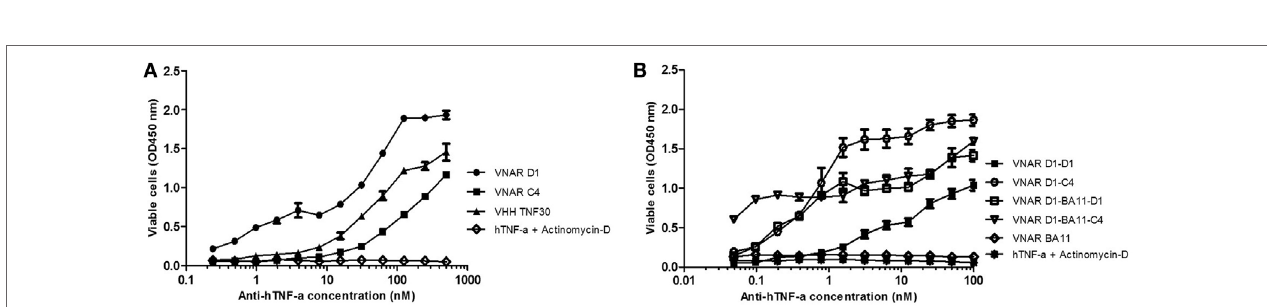
FigUre 3 | Efficacy assessment in standard L929 cell-based assay. Neutralization of 0.3 ng/ml hTNF- α -induced cytotoxicity in an actinomycin-D primed fibrosarcoma cell line (L929). (a) hTNF- α neutralization assay with anti-hTNF- α monomeric constructs at a maximum concentration of 500 nM. Results are the mean ± SD ( n = 2) with two replicates per experiment. (B) Neutralization with multivalent anti-hTNF- α variable new antigen receptor (VNAR) constructs at maximum concentration of 100 nM. Results are the mean ± SEM ( n = 3) with two replicates per experiment. Results (B) were analyzed statistically using a two-way ANOVA with Bonferroni’s multiple comparison post hoc test. VNAR BA11 was included as a negative control domain in all assays where D1–BA11–D1 and D1–BA11–C4 were tested.